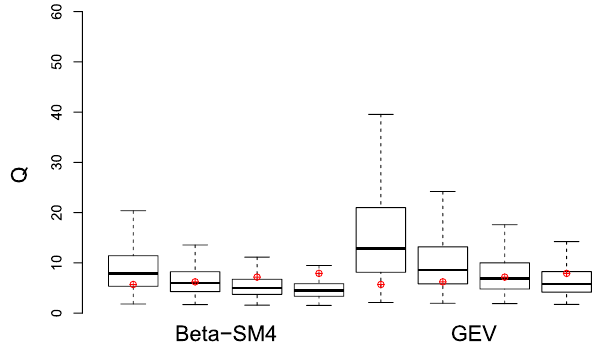
Figure 4. Box-plot of quantiles obtained from resampling procedure, sorted in decreasing order of i . Observed quantiles of udometric coefficient are depicted in red.